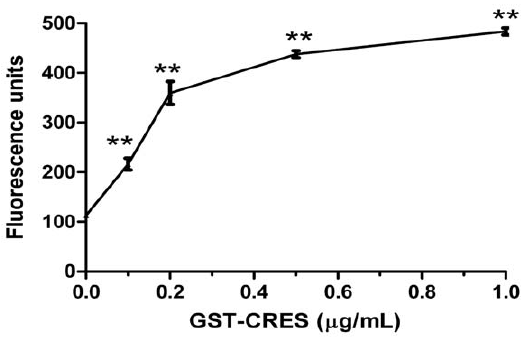
Figure 5. Permeabilization of bacterial membranes mediated by CRES. * p , 0.05, ** p , 0.01.